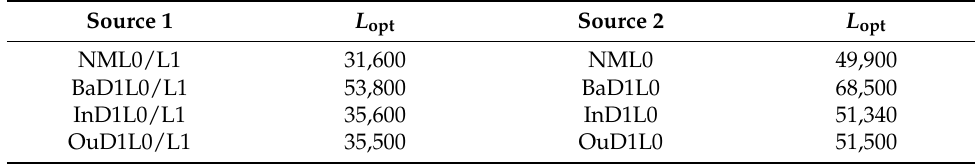
Table 5. L opt corresponding to the single faults.